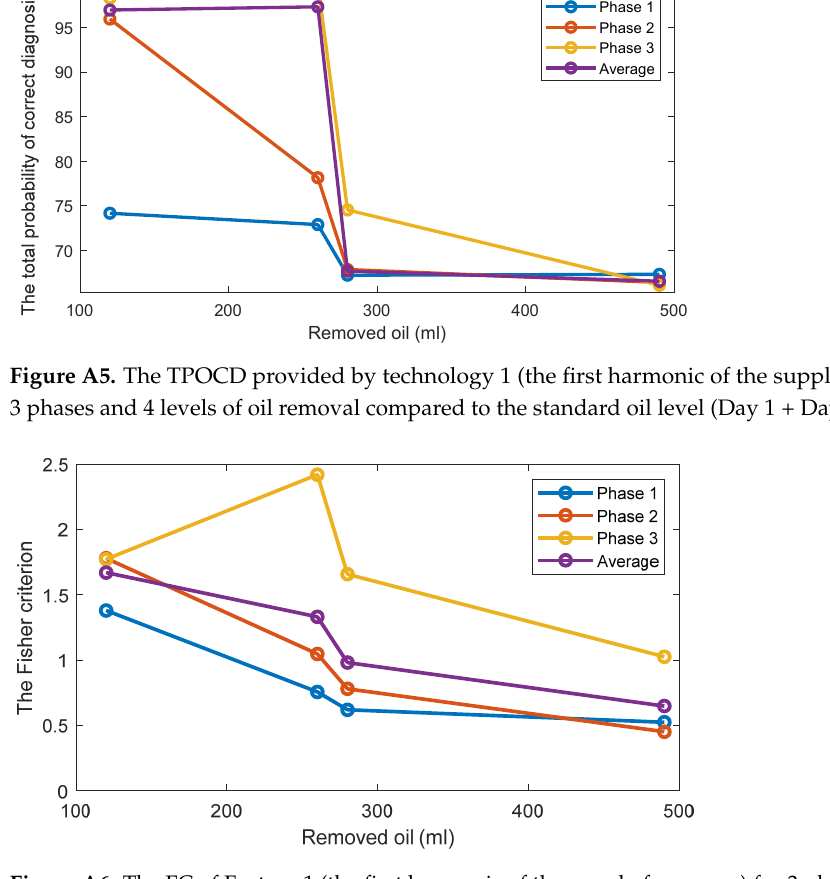
Figure A6. The FC of Feature 1 (the first harmonic of the supply frequency) for 3 phases and 4 levels of oil removal compared to the standard oil level (Day 1 + Day 2).